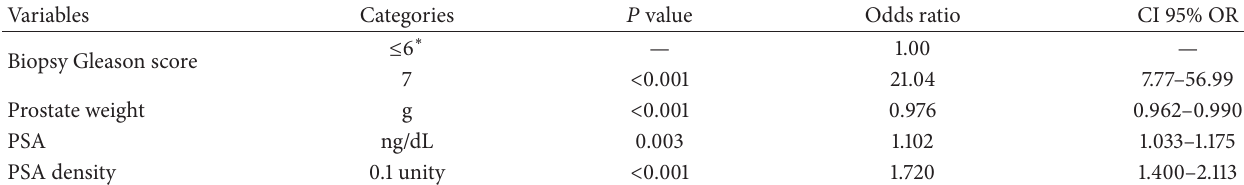
Table 3: Significant variables on multivariate logistic regression analysis to preoperatively predict Gleason discordance.